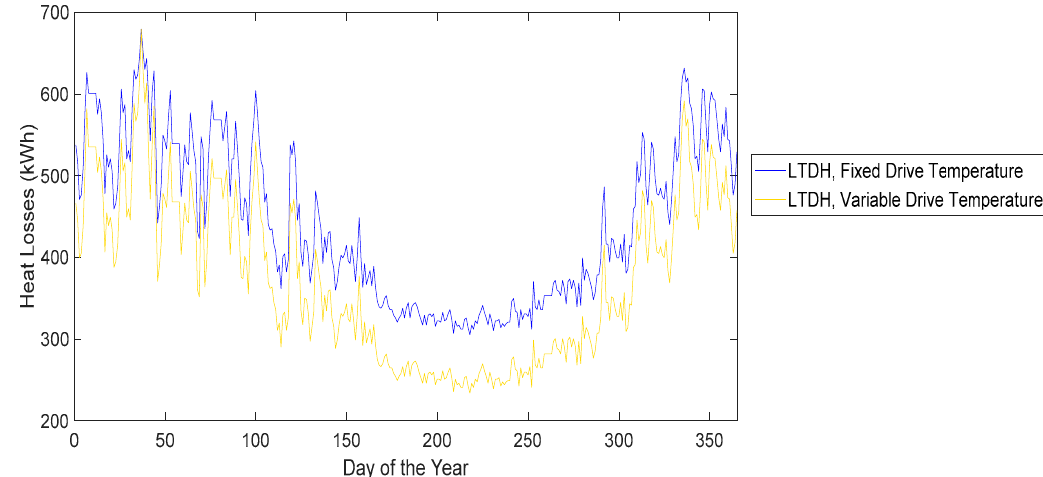
Figure 8. Comparison of losses in a low temperature network along the year with fixed and variable network temperatures.